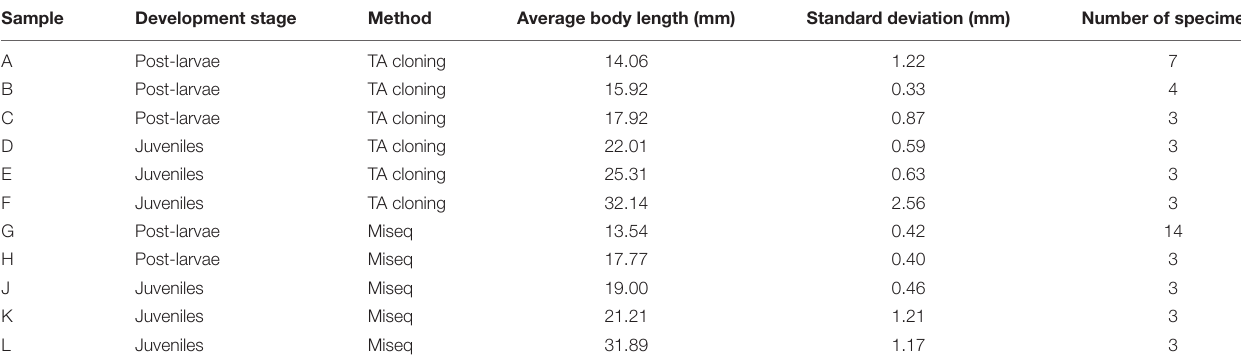
TABLE 1 | Larimichthys polyactis samples, developmental stages, analysis methods, and body